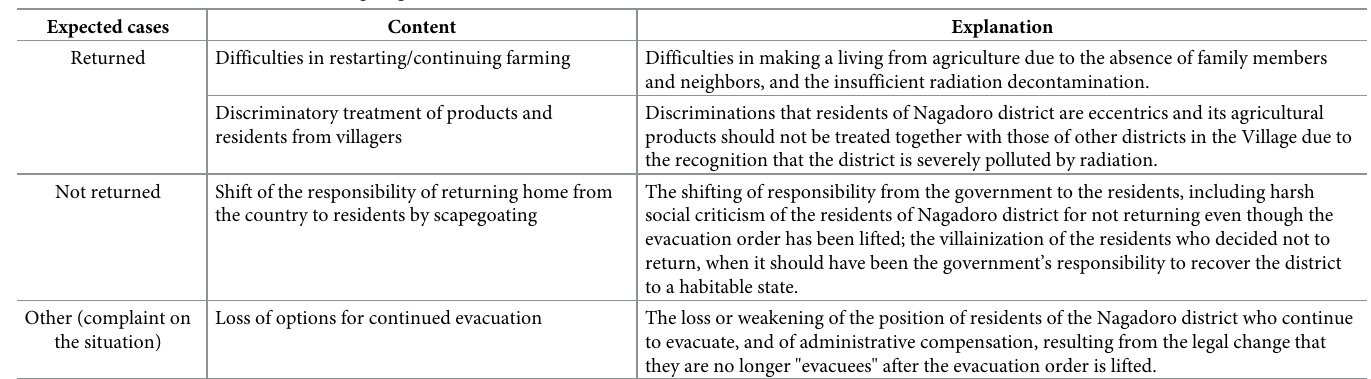
Table 1. Concerns related to the returning Nagadoro